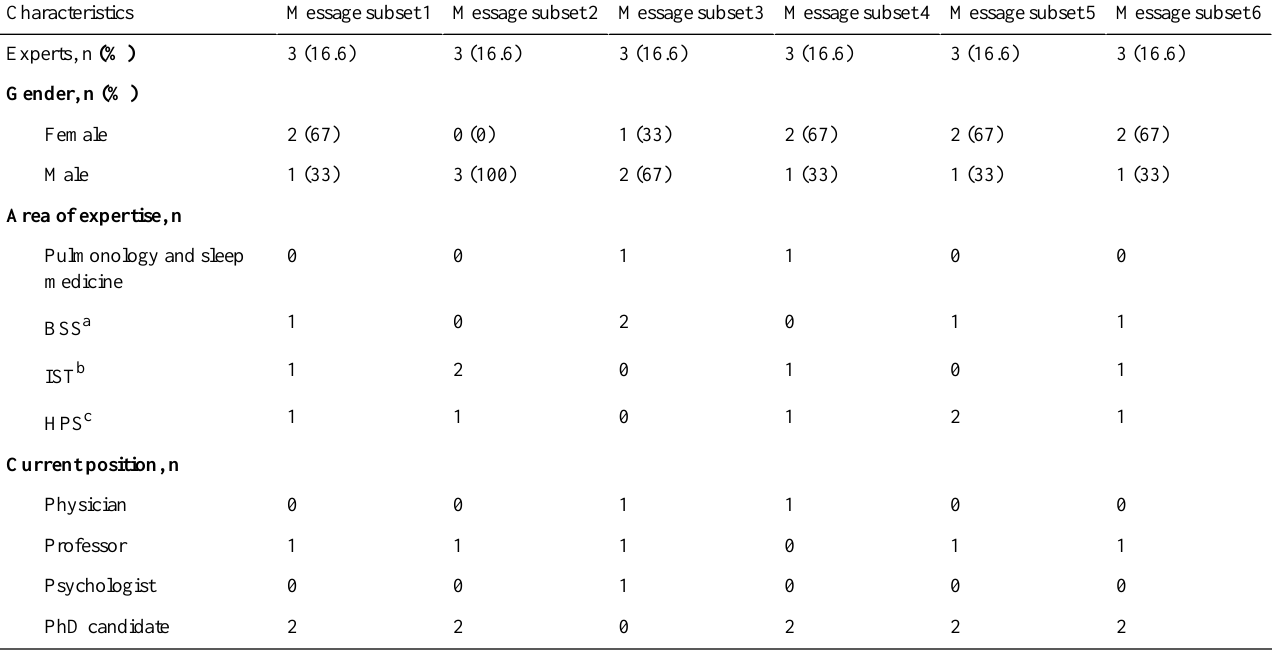
Table 1. Experts’characteristics for message relevance